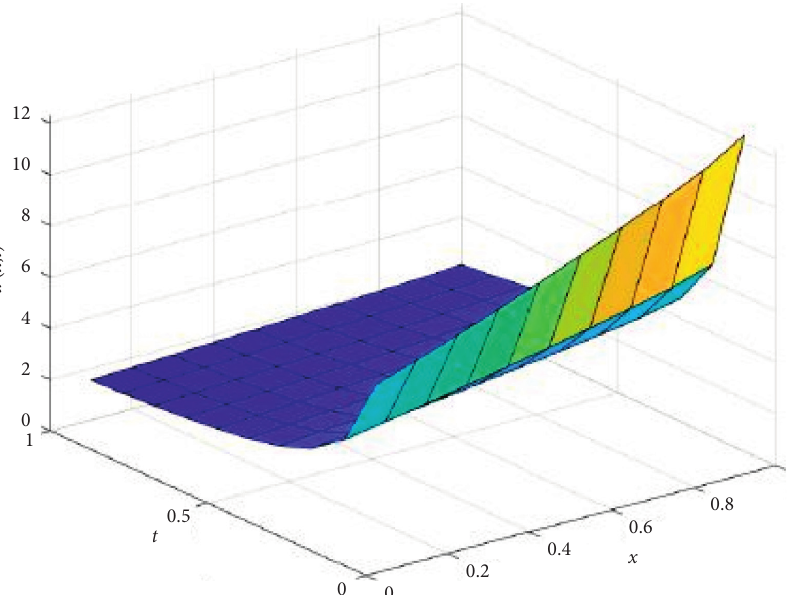
Figure 4: 3D plot of equation (52) with the parameter values c